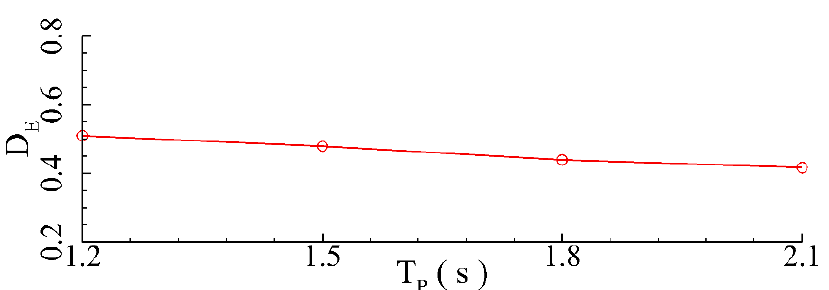
Figure 22. Dissipation rate of the local maximum wave height under peak wave periods.